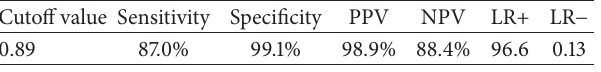
Table 4: Validity of the ABPI of 0.89 as an indicator of PAD. Cutoff value Sensitivity Specificity PPV